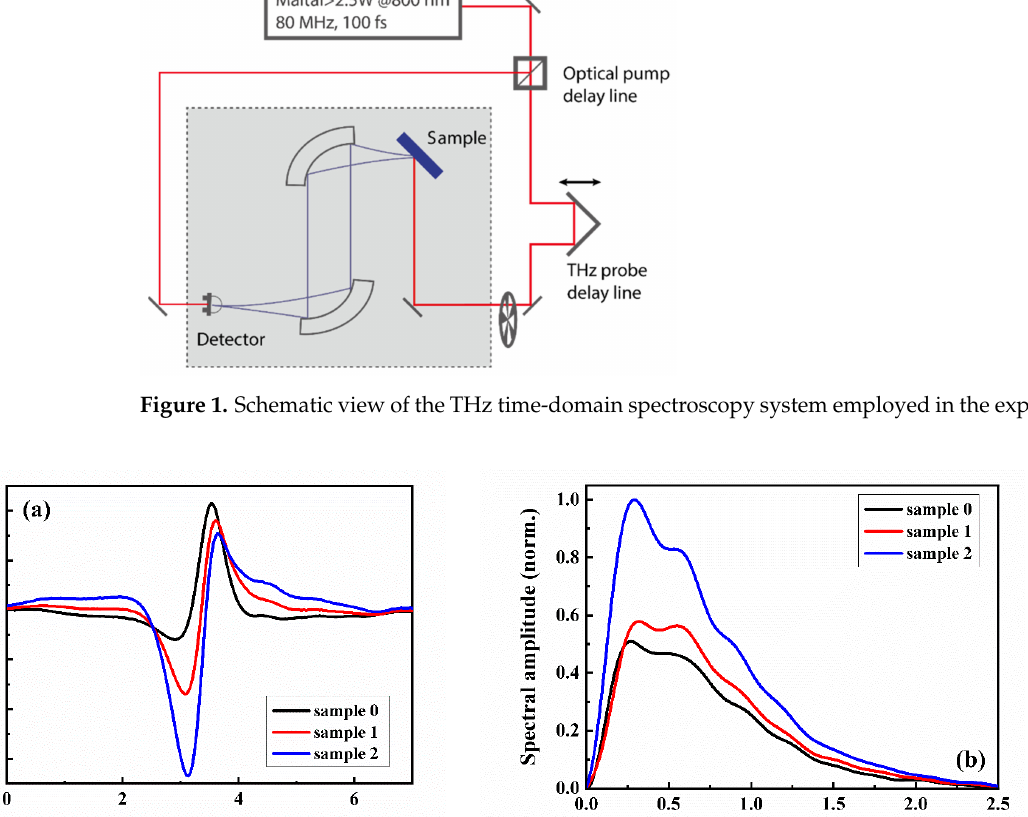
Figure 1. Schematic view of the THz time-domain spectroscopy system employed in the experiments.